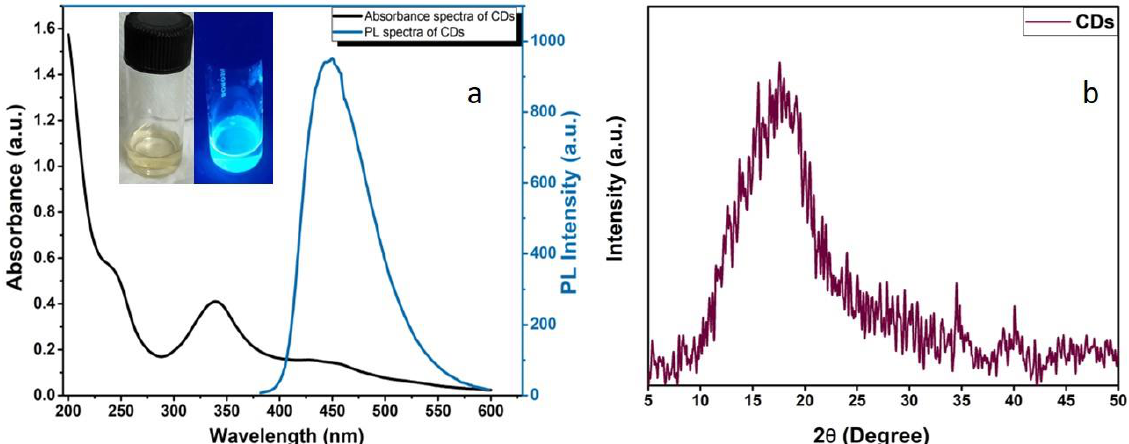
Figure 4. UV-PL graph of CDs and inset images of as-prepared pale-yellow coloured carbon dots solution in normal and UV light ( a ) and XRD pattern of CDs ( b ).